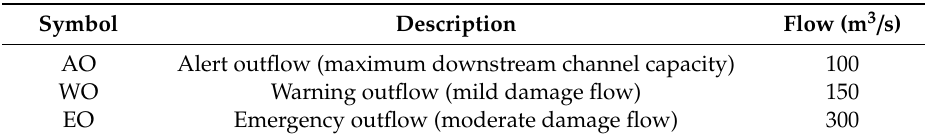
Table 2. Downstream river characteristic capacity